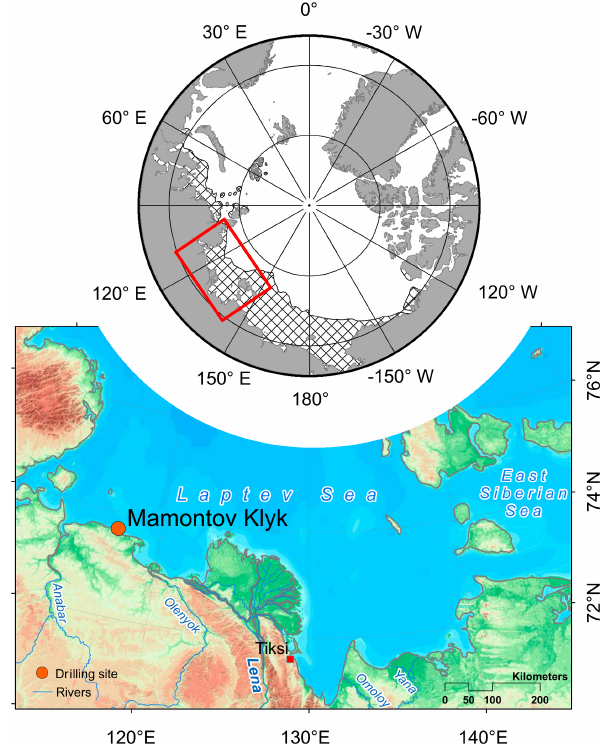
Figure 1. Geographical location of the study site. Location of the Laptev Sea on a circumpolar perspective map and the potential ex- tent of submarine permafrost (striped area; based on Brown et al., 2002), as well as the geographical location of the drilling site at Cape Mamontov Klyk in the western Laptev Sea (modified from Overduin et al.,